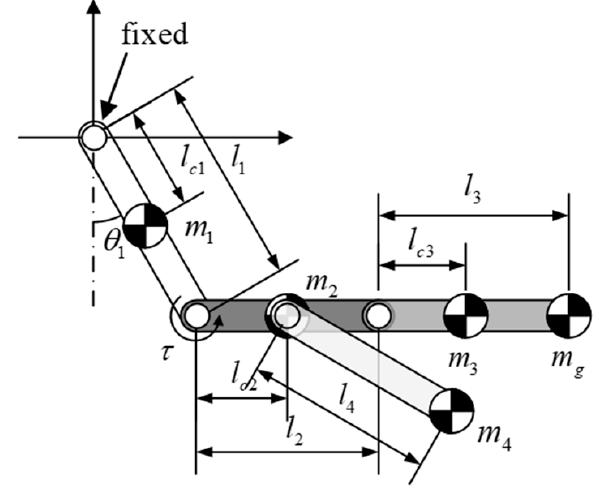
Figure 6. Design parameters with the robot modeled as a four-link system. Modeling of the tail link is simplified as a point mass pendulum comprising a tail actuator with electronic components for motion control and power delivery. The length of the tail link could be extended to increase swing momentum; however, this would impose length l 4 is half the total robot length, as shown in Figure 5. As shown in Figure 6, the resulting mass m 4 is approximately 0.5 kg. Note that the design of the gripper does not depend on the specifications of the other links, which means that it can be designed